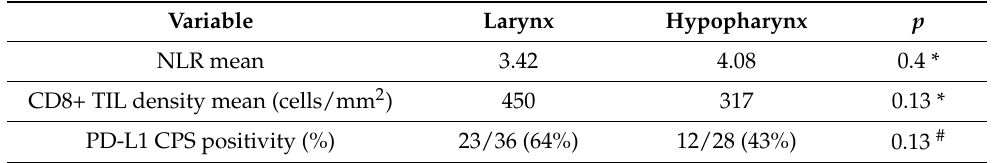
Table 6. NLR values, CD8+ TIL density, and PD-L1 CPS expression according to tumor